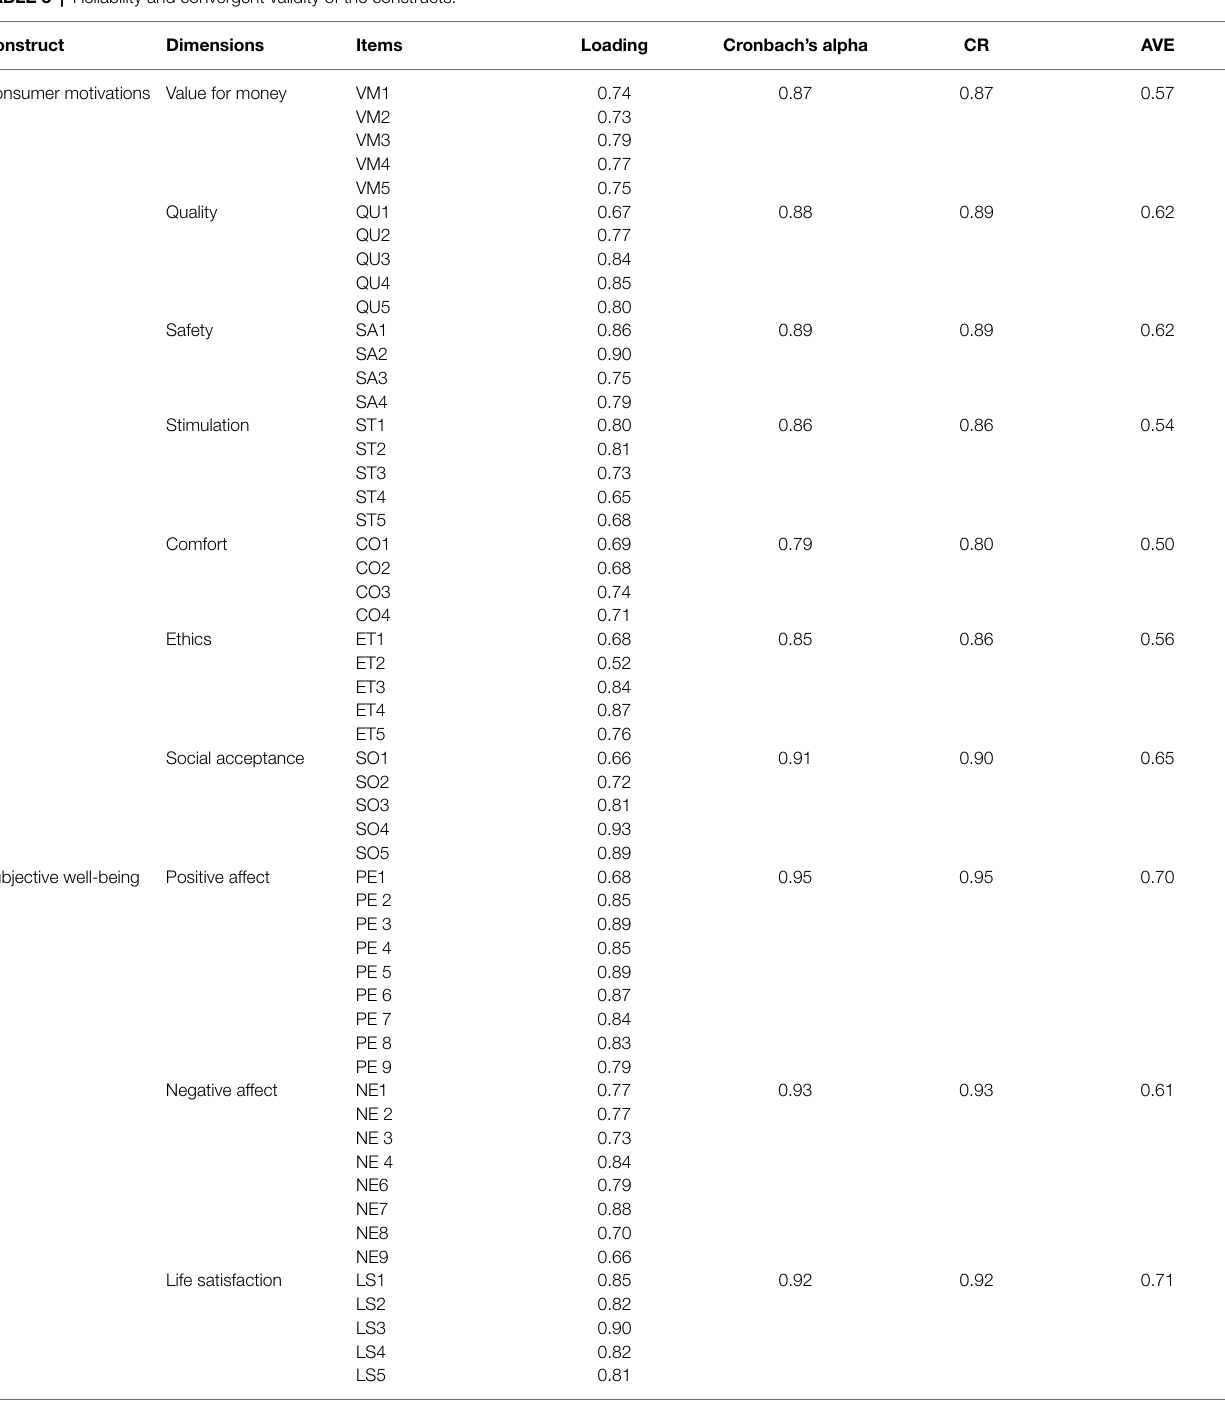
TABLE 3 | Reliability and convergent validity of the constructs. Construct